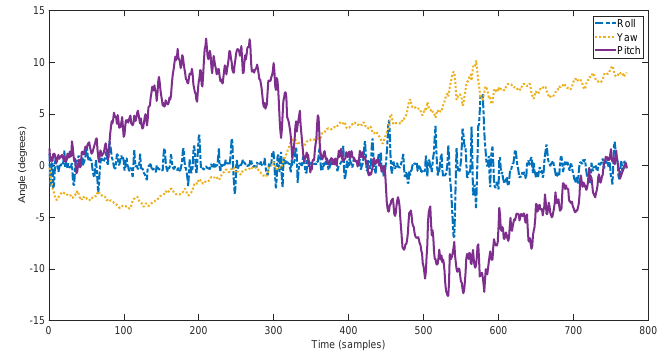
Figure 10. Evolution of the roll, pitch, and yaw angles during the obstacle climbing